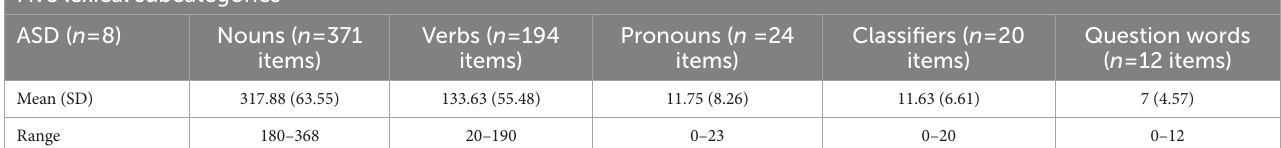
TABLE 2 PCDI vocabulary production scores. Five lexical subcategories